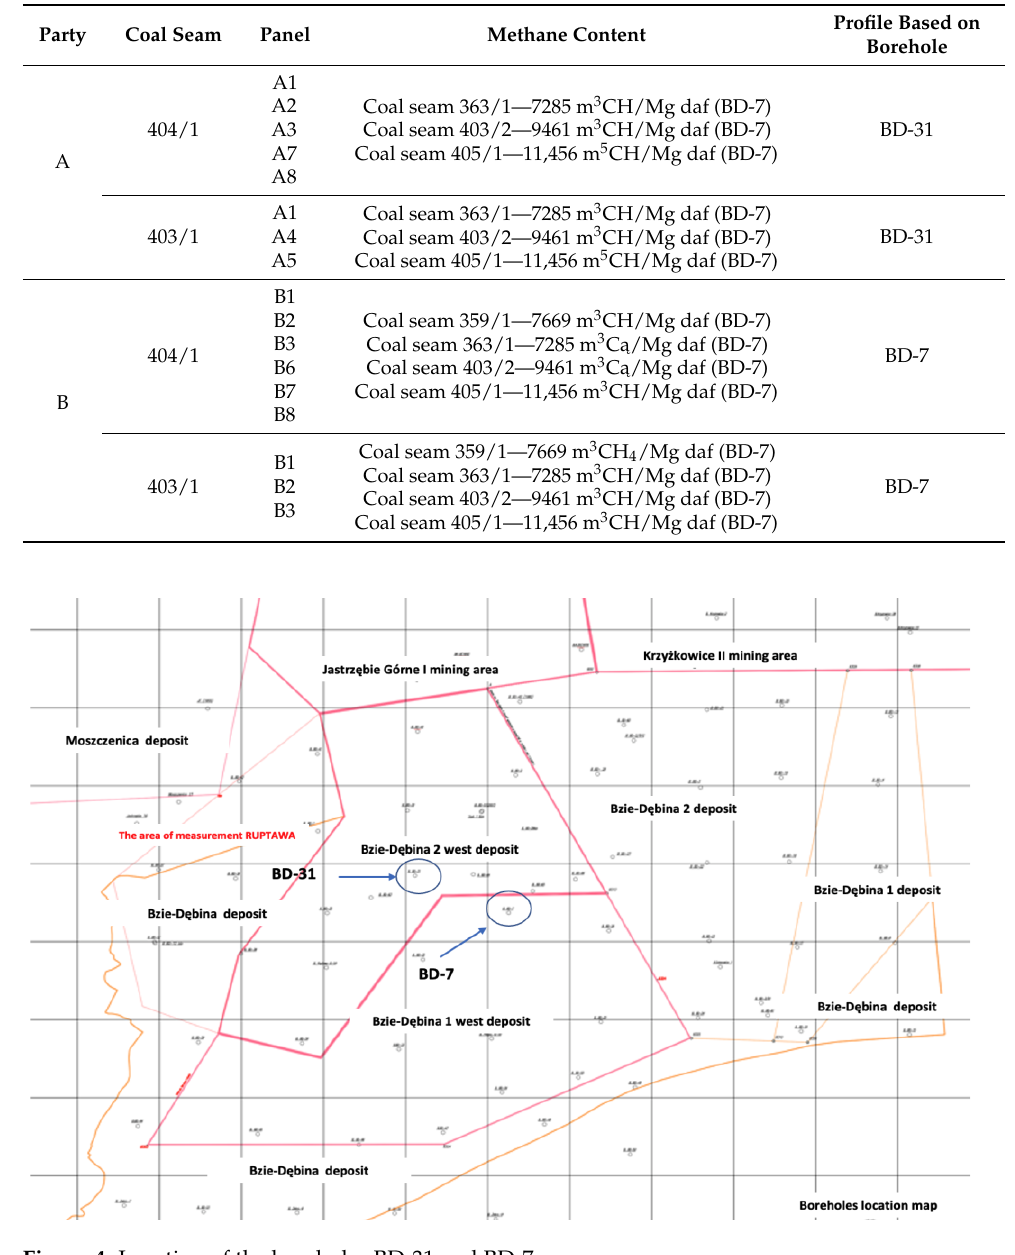
Figure 4. Location of the boreholes BD-31 and